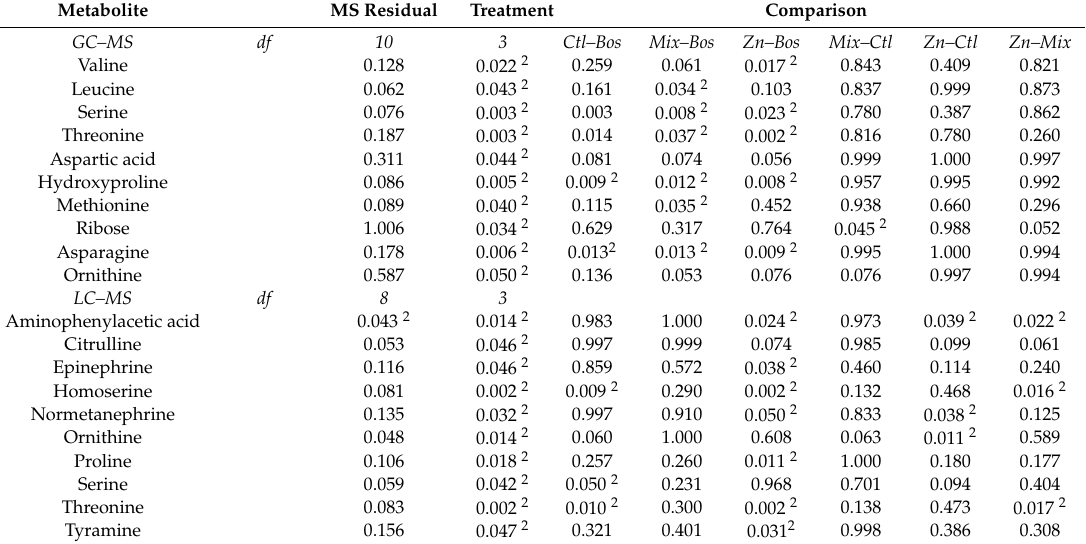
Table 2. One-way analysis of variance for individual metabolites, measured following exposure to treatments (zinc, boscalid, and